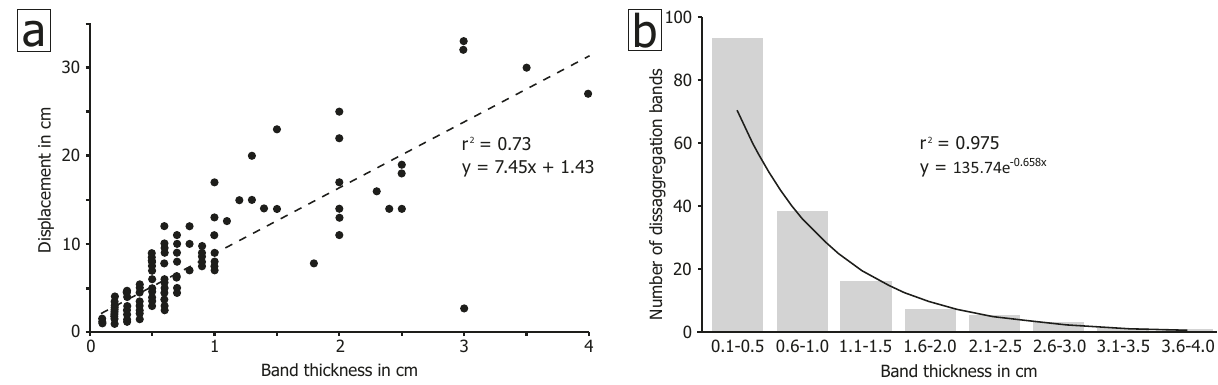
Fig. 2 Field data of 155 disaggregation bands exposed in the Freden outcrop. a Thickness/displacement relationship; band thickness shows a linear relationship to displacement. b Thickness/frequency of disaggregation bands, showing a power-law distribution. The disaggregation bands have a median thickness of 0.2